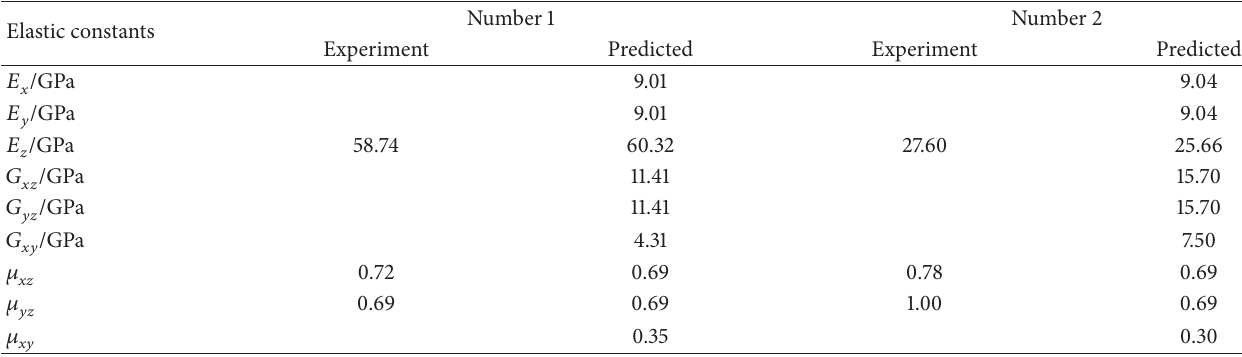
Table 3: Comparison of the elastic constants predicted by the model and experimental